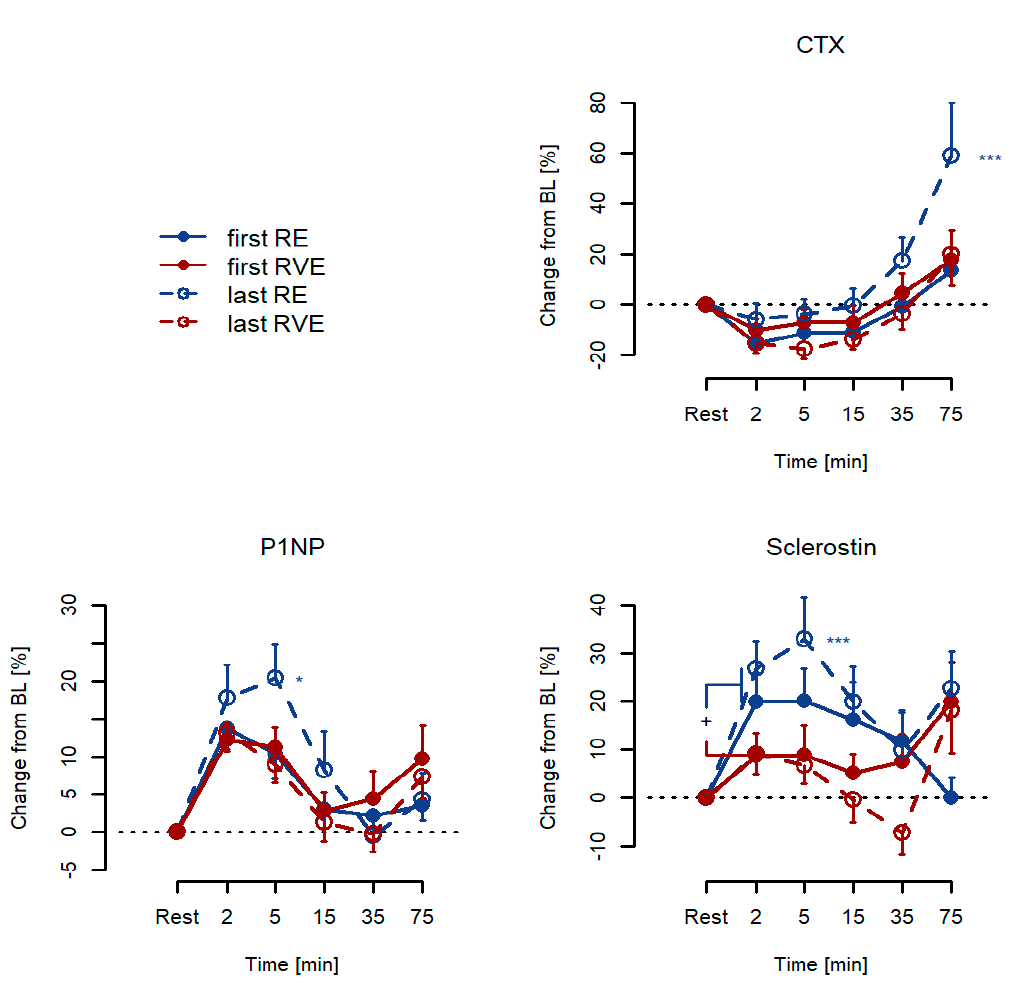
Figure 2. Acute responses to exercise training for serum CTX, P1NP, and sclerostin, given as percentage changes from resting baseline levels for both RE ( n = 13) and RVE ( n = 13) groups. * p < 0.05, *** p < 0.001.